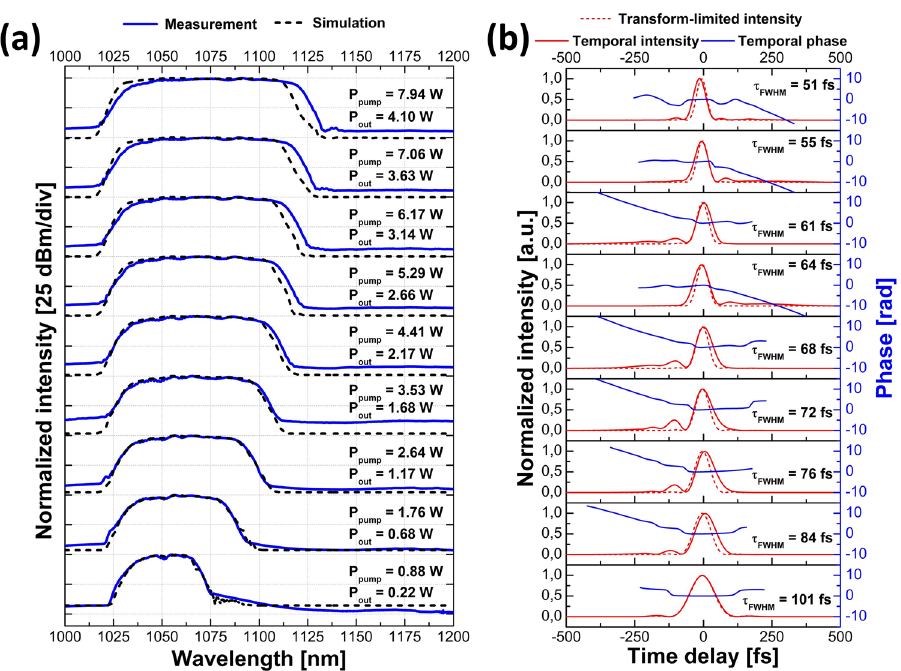
Figure 3. Characterization of the amplified pulses for the high-repetition-rate laser source: ( a ) comparison of the simulated spectra at the output of the amplifier (dashed black line) and traces measured with the OSA (solid blue line) with the corresponding pump powers and average output powers after the amplifier; ( b ) FROG- retrieved temporal intensity (solid red line) of the compressed pulses together with temporal phase (solid blue line), transform-limited intensity (dashed red line) and the corresponding pulse